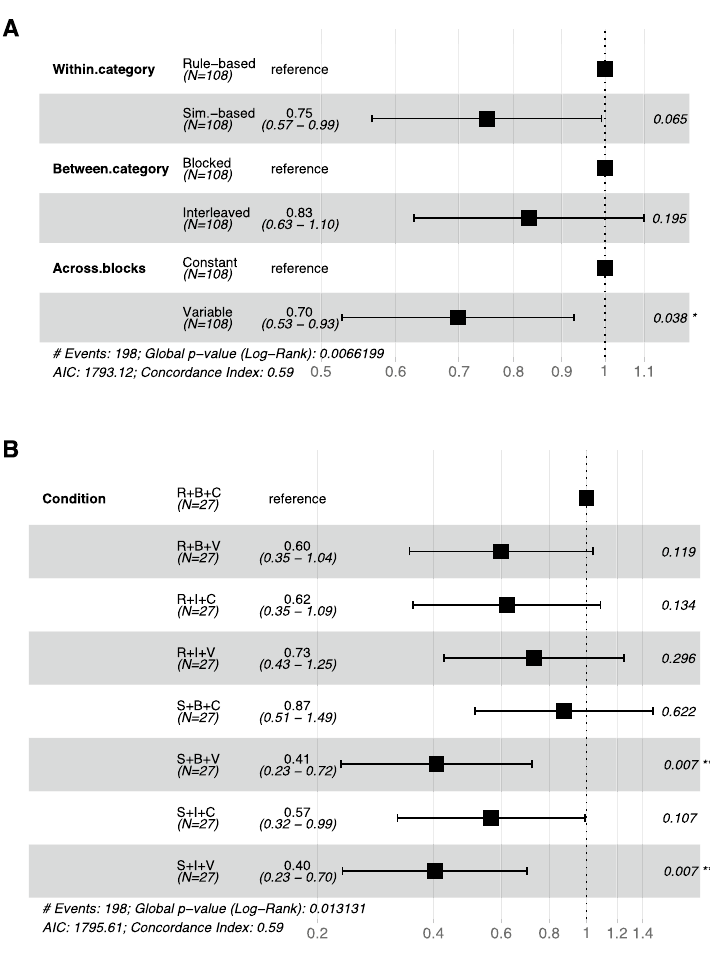
Figure 4. Results of the application of the Cox model as a function of the types of order, taken separately ( A ) and combined ( B ). Hazard ratios and their 95% confidence intervals are showed in the middle. Significance values of the Wald test (showed on the right) were corrected for multiple comparisons using the Benjamini- Hochberg correction with a FDR ≤ .05